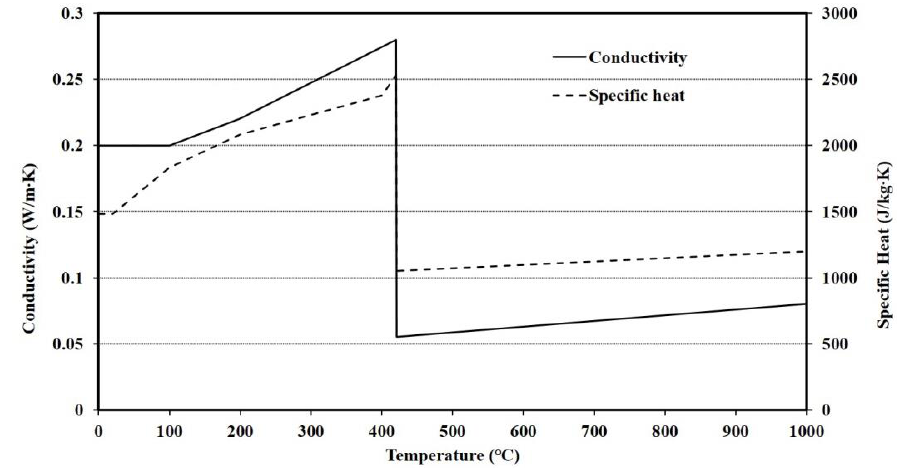
Figure 3. Thermal properties of polymers at elevated temperatures [11].